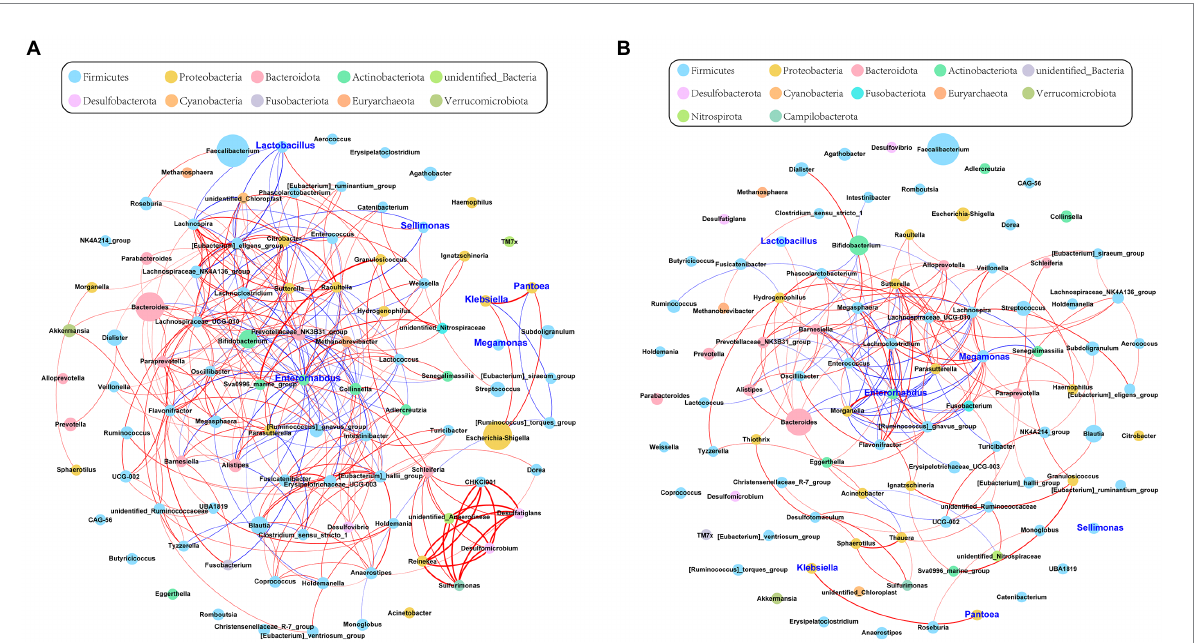
FIGURE 2 The network of gut microbiota during late pregnancy (based at the genus level). Each node was annotated with the name. The size of the nodes indicates their relative abundance in each group. The color of each node represents the phylum. The red and blue lines represent the positive and negative relationships between each node, respectively. (A) The microbial community was complex and balanced at baseline (30–32 weeks of gestation). The genera of Proteobacteria (orange) were pointedly active. (B) As gestational age progressed, the whole network tended to be looser. The relative abundance of Megamonas (sky blue) and its correlations with other genera were significantly increased in the full-term pregnancy. Enterorhabdus (green) held a central position during late pregnancy. However, the microbial connections were weak and varied. The absolute value of Spearman rank correlation coefficient was >0.6, and P was